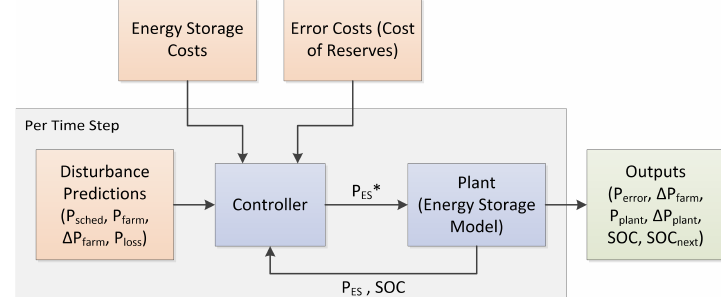
Figure 3. Model predictive control (MPC) controller